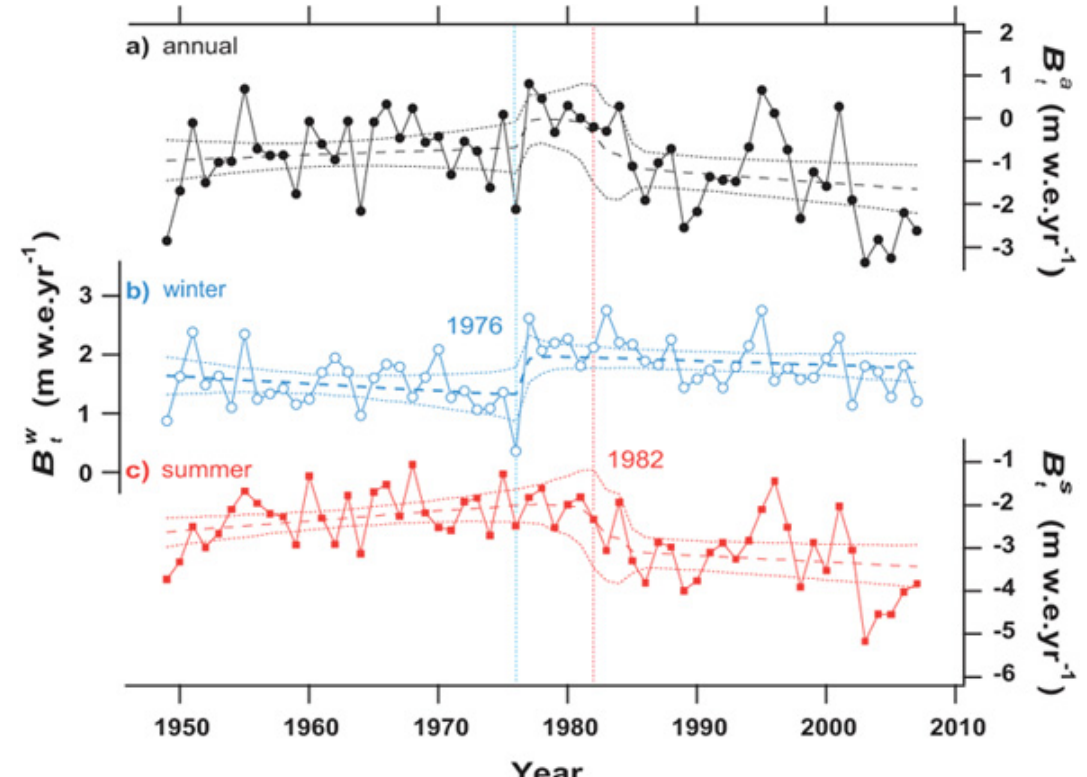
Fig. 2. (a) Annual, (b) winter, and (c) summer glacier-wide balances at Sarennes extracted from the analysis of variance. Dashed lines are trends and dotted lines are 95% credible intervals for the trends. The blue and red vertical dotted lines highlight the breakpoints in winter and summer balances in 1976 and 1982, respectively.